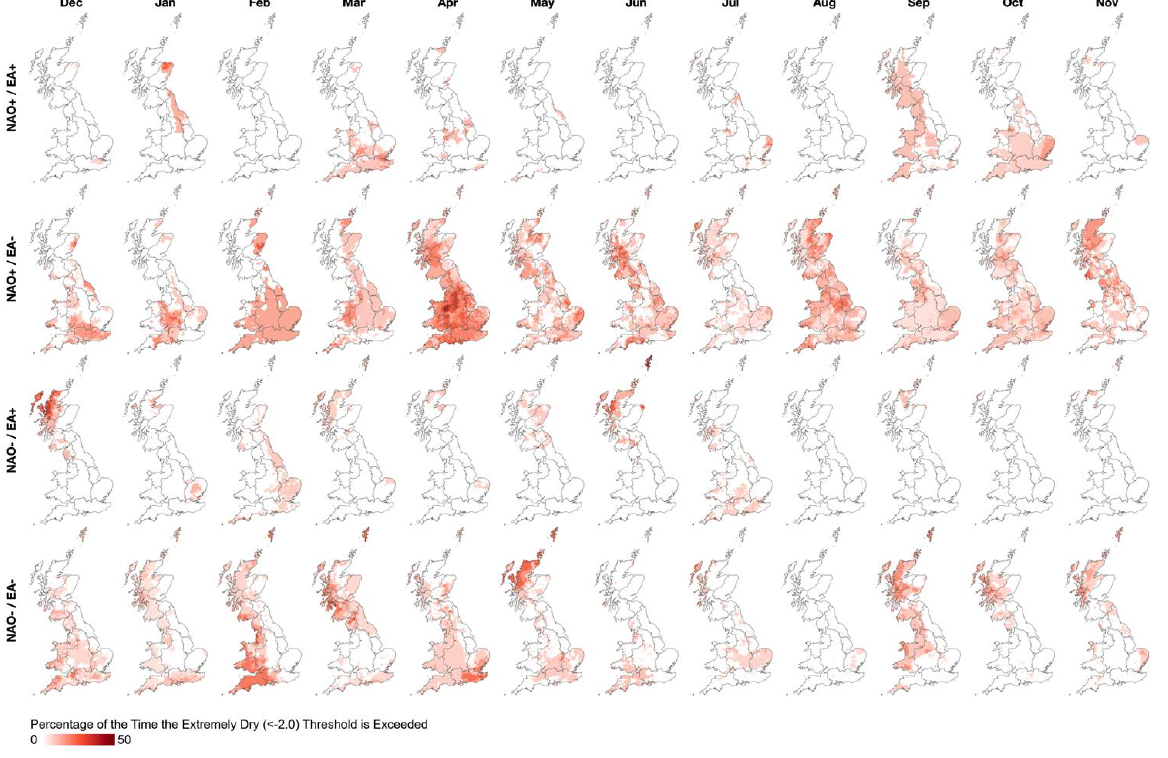
Figure 11. As per Figure 7 but for the extremely dry (SPI-1 < − 2.0) SPI-1 class. The SPI-1 class frequency analysis shows spatio-temporal variability in the extent of wet/dry extremes relative to the combination phases of the NAO and EA teleconnections.